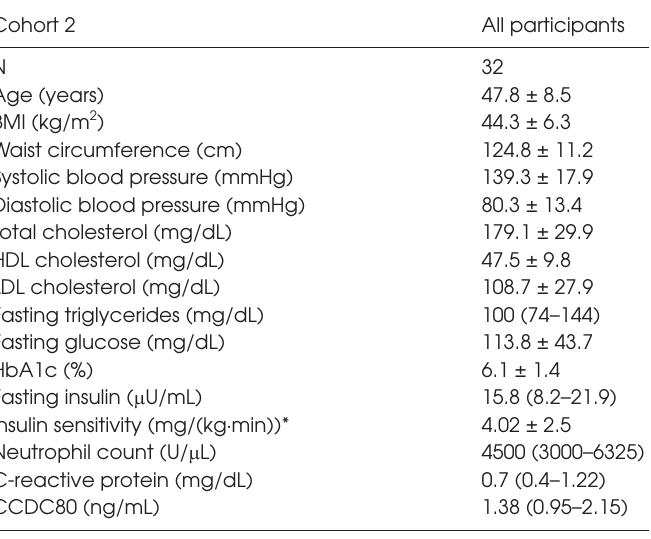
Table 2. Anthropometric and analytical characteristics of the morbidly obese